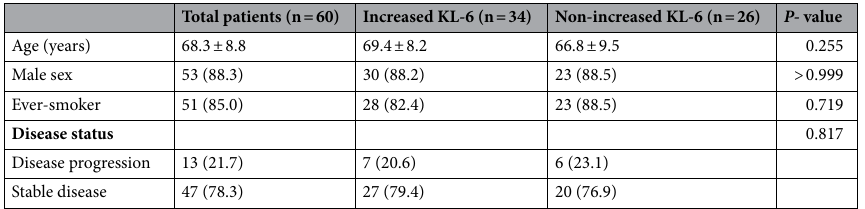
Table 4. Comparison of disease progression in the increased KL-6 vs. non-increased KL-6 group. Data are presented as the mean ± standard deviation or number (%), unless otherwise indicated. KL-6: Krebs von den